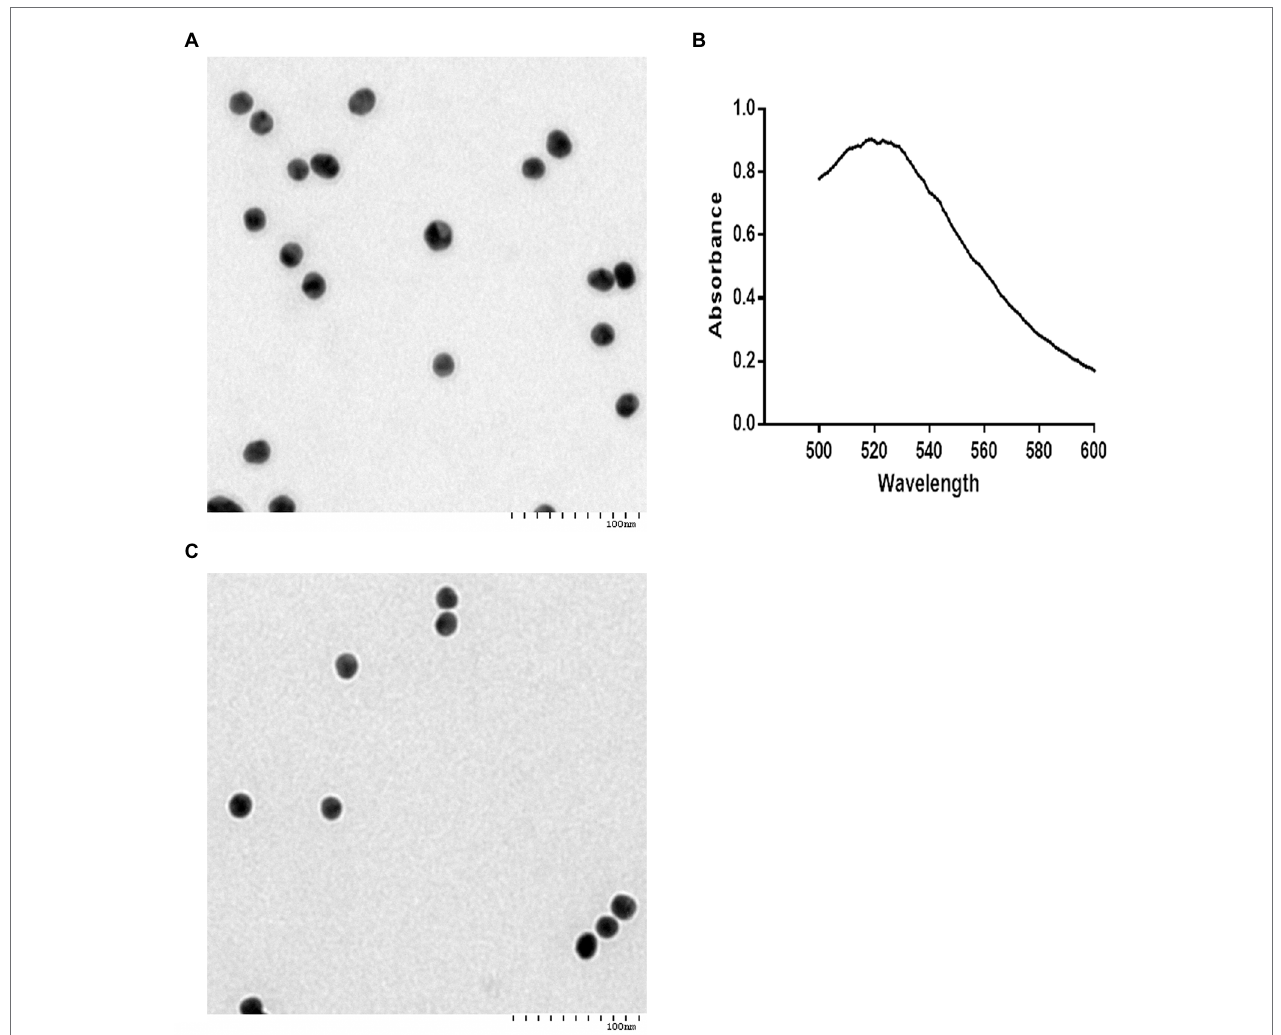
FIGURE 3 | Characterization of the colloidal gold probes. Analysis of the 20-nm colloidal gold solution (A,B) . (A) About 20-nm colloidal gold particles appear round or oval observed by transmission electron microscopy (TEM). TEM indicated that the diameters of the colloidal gold particles were approximately 20